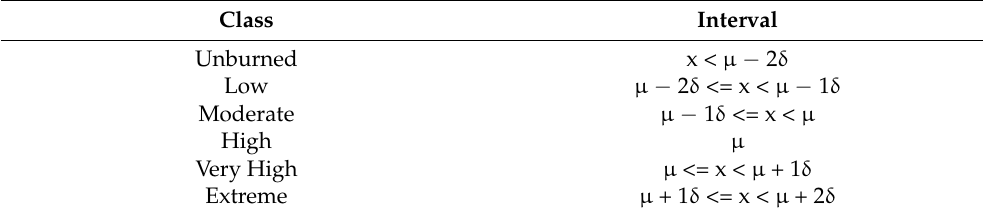
Table 3. Burn severity classes ( µ : Mean; δ : Standard deviation, Source: KFRI, 2013). Class Interval Unburned x < µ − 2